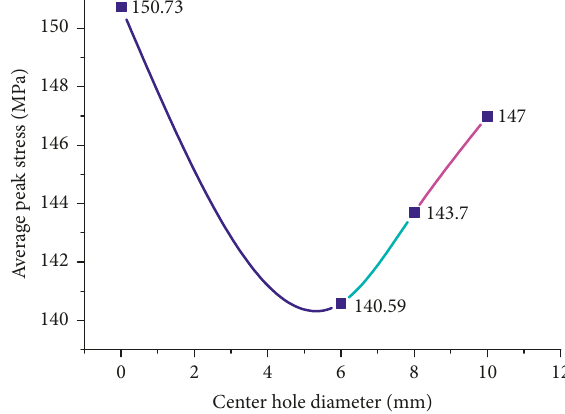
Figure 9: Average effective elastic modulus of each specimen group. Figure 10: Average peak stress distribution of each specimen